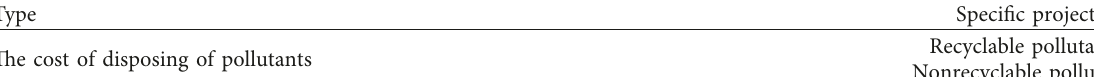
Table 2: Classification of environmental pollution costs.